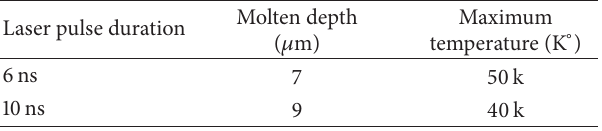
Table 1: Comparison between the Ag NPs produced by 1064 nm has 6 and 10ns pulse